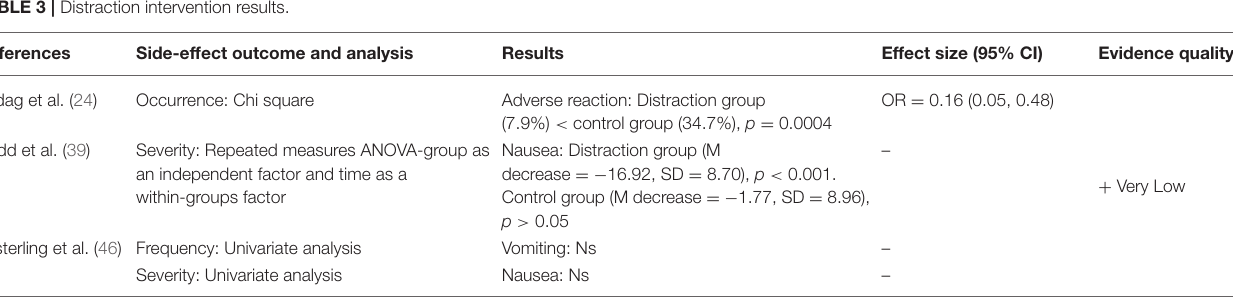
TABLE 3 | Distraction intervention